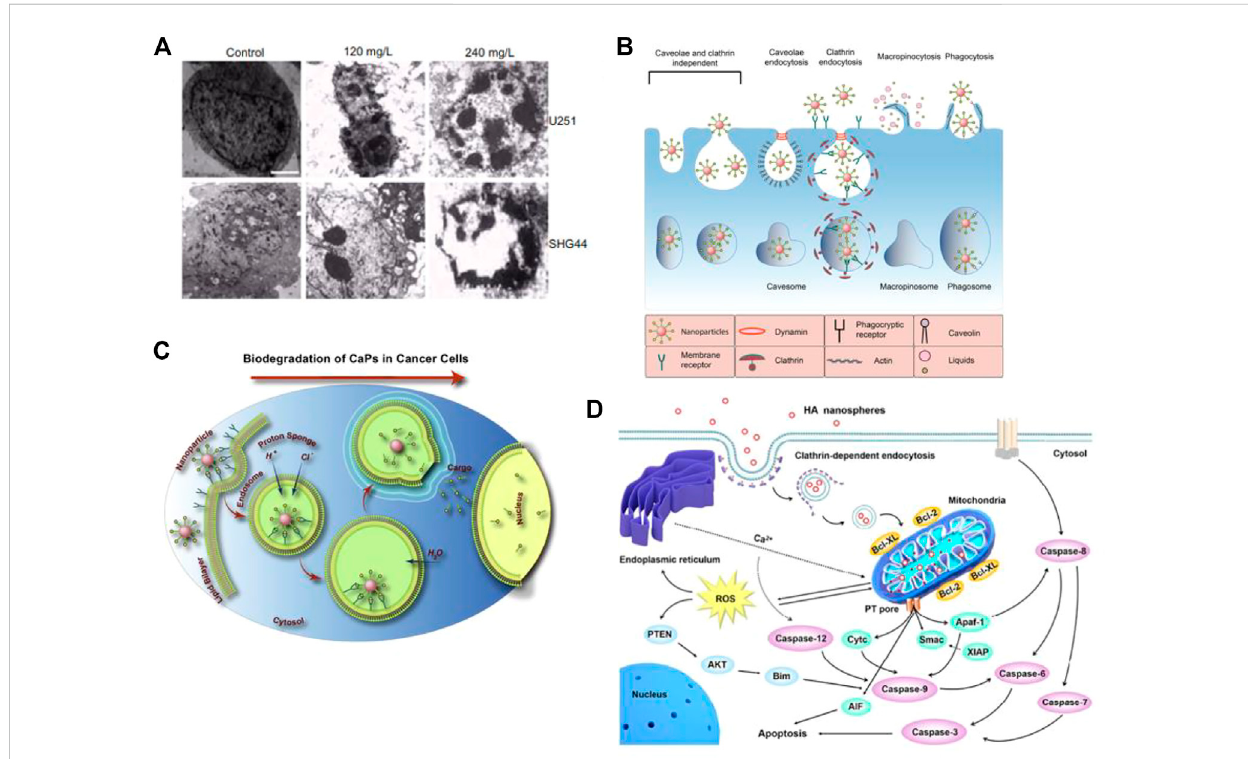
FIGURE 1 Cytotoxicity of nHAp on tumor cells. (A) Treatment with nHAp caused changes in the morphology of human glioma SHG44 cells and U251 cells. (B) Tumor cells engulf nHAp through various endocytic mechanisms. (C) nHAp is degraded in the acidic microenvironment of lysosomes, and H + diffuses into the cytoplasm through proton pumps. To maintain charge neutrality, Cl − and H 2 O enter the lysosome, causing lysosome swelling and rupture, releasing large amounts of Ca 2+ , PO 4 3- , and OH − , reaching toxic concentrations, inducing cell apoptosis. (D) Illustration of the possible molecular mechanism of the inhibitory effect of nHAp on 4T1 cells. (A) Reproduced with permission (Chu et al., 2012). Copyright 2012, Int J Nanomedicine. (B) , (C) Reproduced with permission (Khalifehzadeh and Arami, 2020). Copyright 2020, Advances in Colloid and Interface Science. (D) Reproduced with permission (Zhao et al., 2018). Copyright 2017, ACS